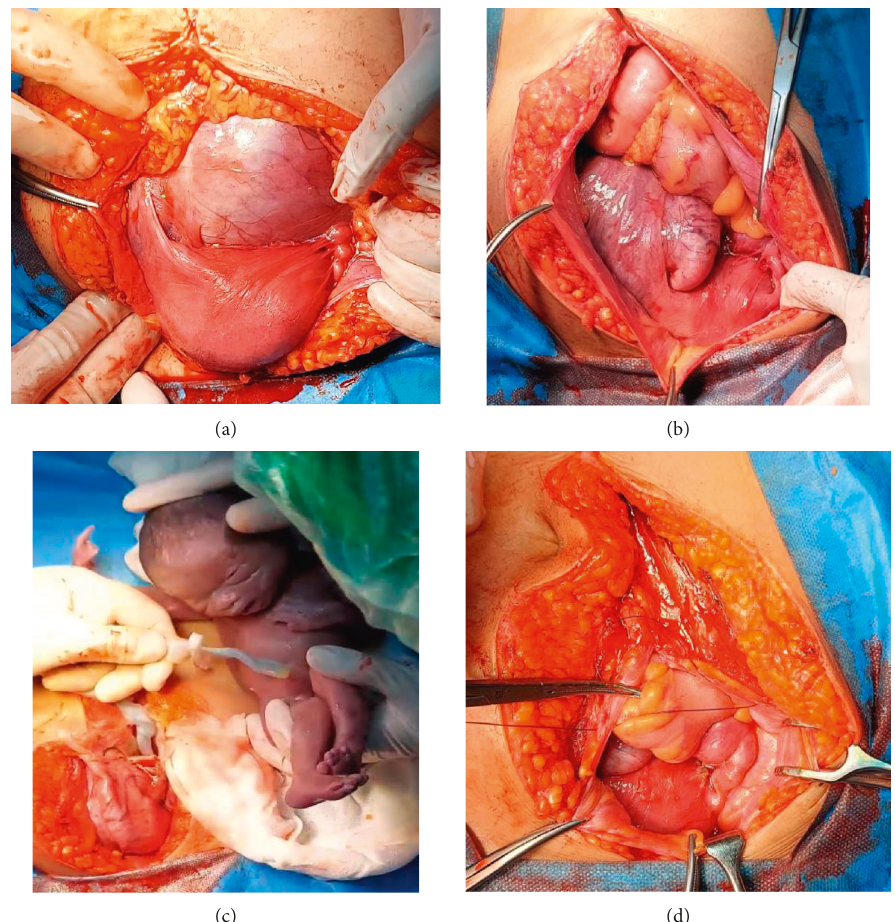
Figure 2: (a) Abdominal gestational sac. (b) The placenta. (c) Delivering the baby. (d) The placenta left in site.